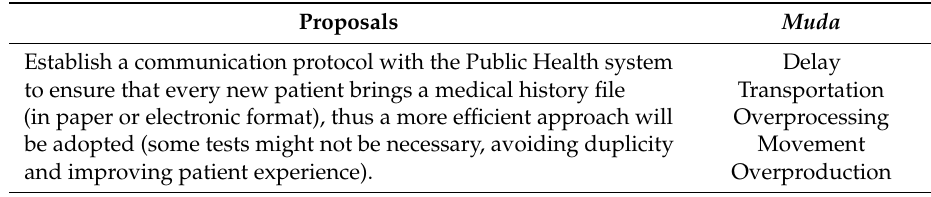
Table 5. List of